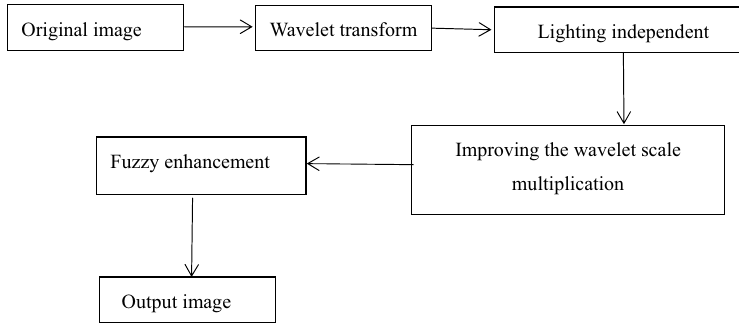
Figure 1: Schematic diagram of the edge detection fl